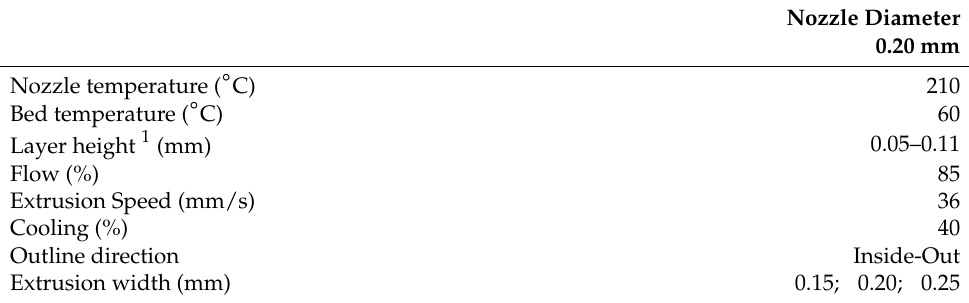
Table 2. Process parameters used in additive manufacturing.